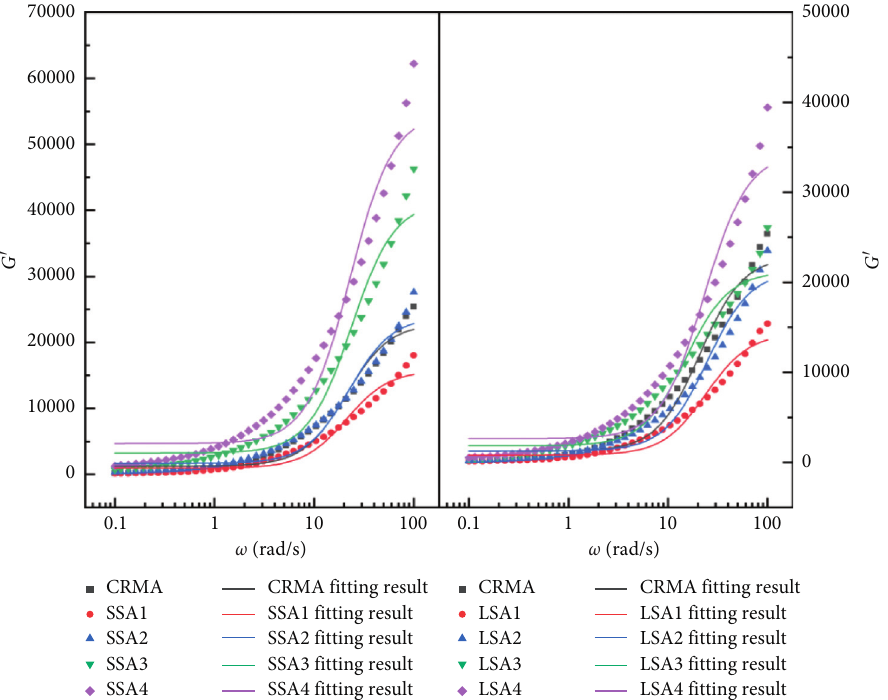
Figure 14: Storage modulus fitting